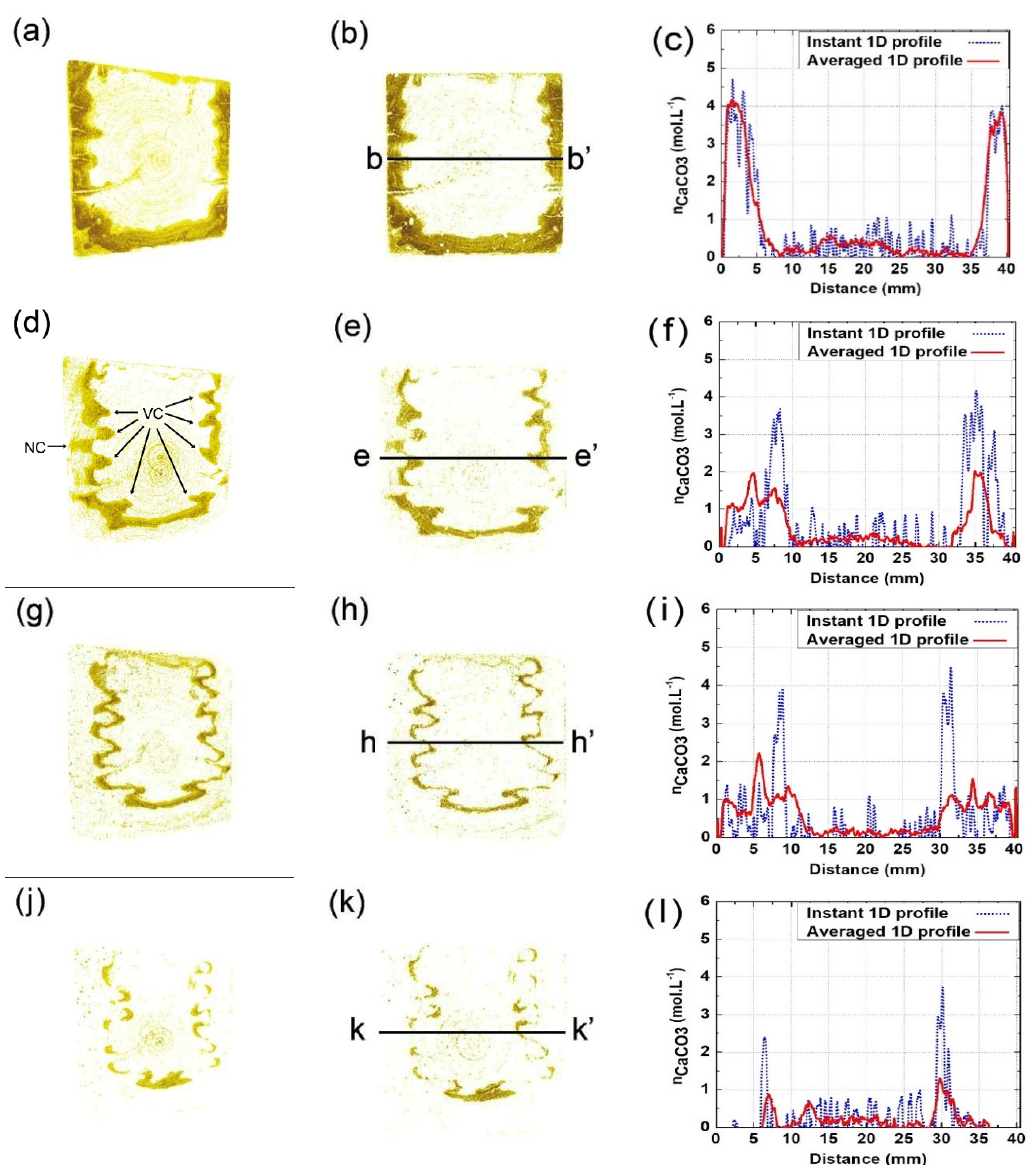
Figure 10. Spatial distributions of CC content: ( a , d , g , j ) show the 3D map of CC content formed between 0 and 3 days; 3 and 7 days; 7 and 14 days; and 14 and 28 days, respectively. ( b , e , h , k ) Show the 2D map of CC content formed between 0 and 3 days; 3 and 7 days; 7 and 14 days; and 14 and 28 days, respectively. ( c , f , i , l ) show the 1D CC profile along b–b’, e–e’, h–h’, and k–k’ and averaged 1D profiles shown in ( b , e , h , k ), respectively.